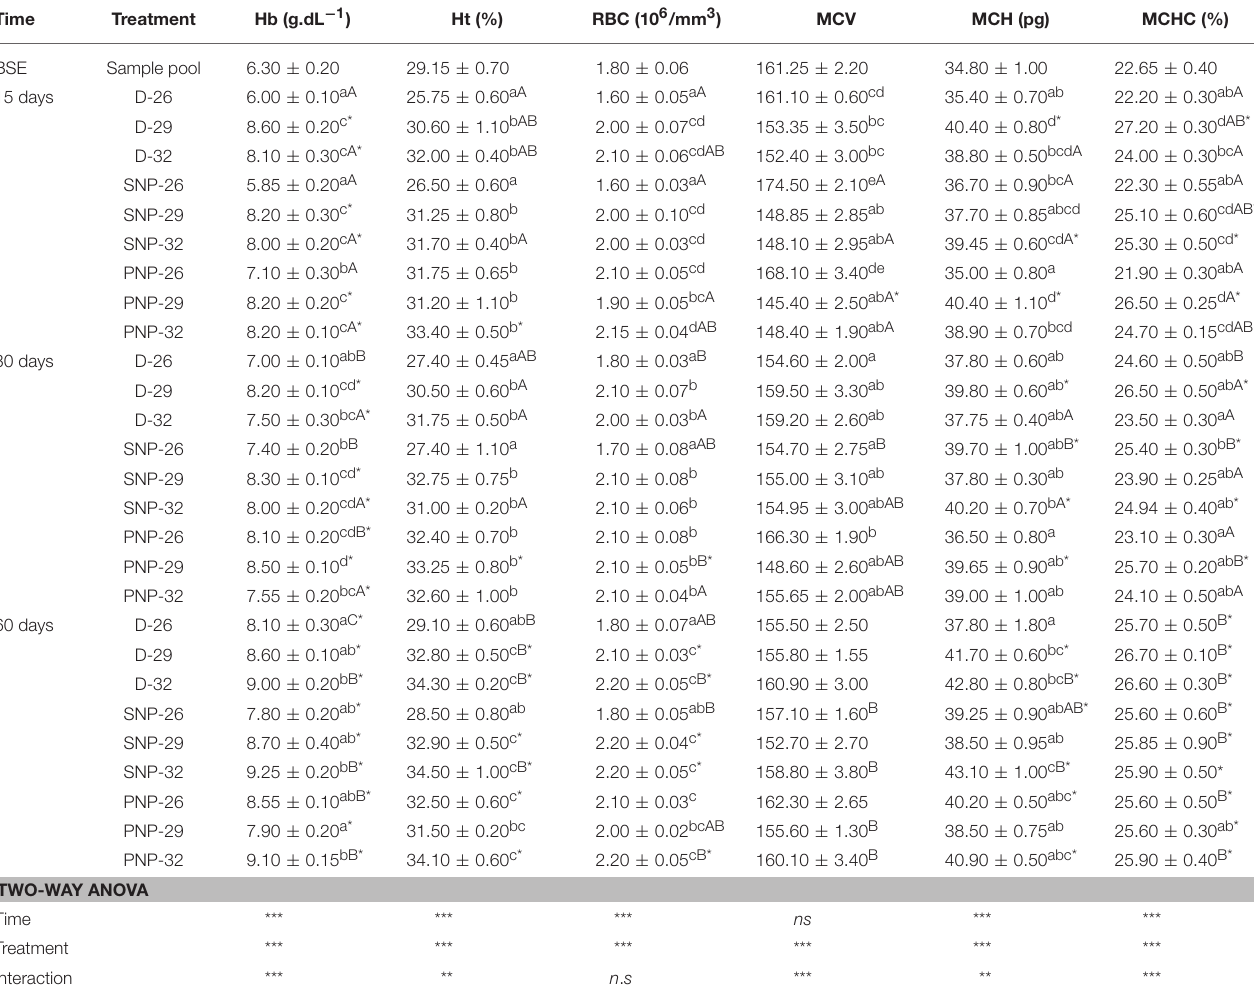
TABLE 4 | Hematological parameters of juveniles of Colossoma macropomum at different experimental trials (D-26, D-29, D-32, SNP-26, SNP-29, SNP-32, PNP-26, PNP-29, and PNP-32). Time